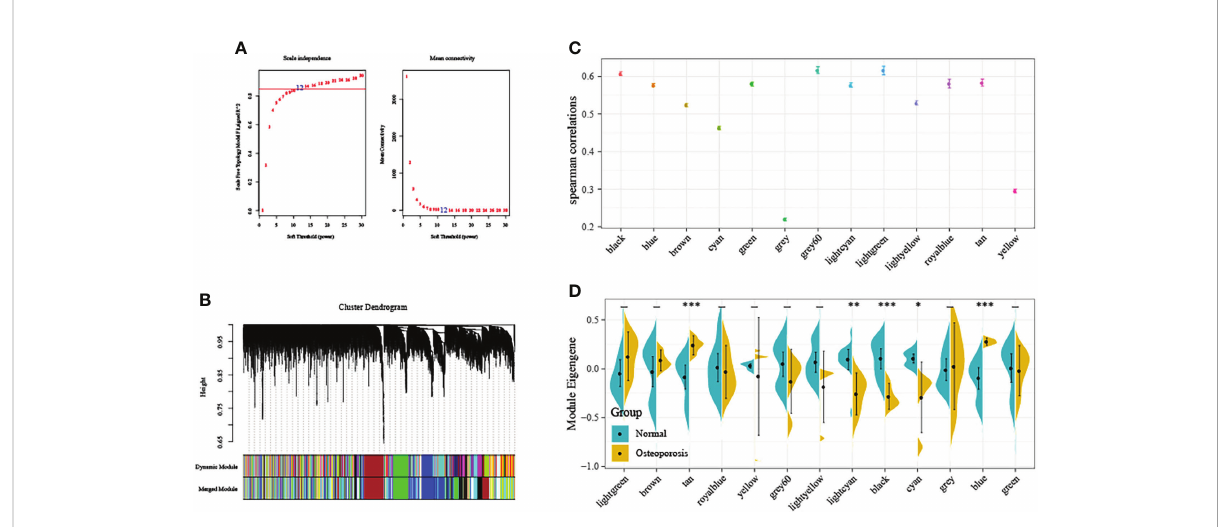
FIGURE 2 Weighted gene co-expression network analysis (WGCNA). (A) Selection of the soft threshold in the WGCNA. The red line represents the correlation coef fi cient, and the fi rst point above the red line is the soft threshold ( b = 5). (B) Clustering of the gene modules. Each designated color represents a gene module, and the genes that could not be grouped into other modules were placed in the grey module. (C) The correlation between ME gene modules and dichotomous phenotypes. (D) The distribution difference of ME in each module between disease and healthy samples. *P<0.05, **P<0.01,